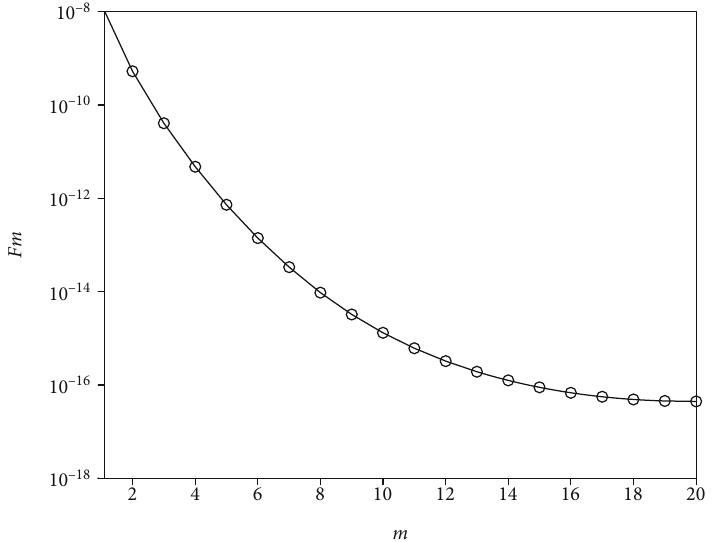
Figure 27: Variation of the LSPM numerical solution F = 0 : 6, Ω = 0 : 1, andHe = 0 : 2 0 : 5, Pr = 10, S = 3, N R